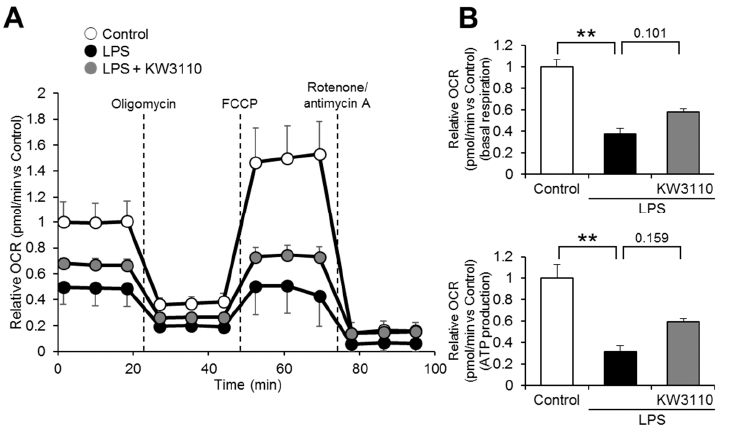
Figure 3. Effects of KW3110 treatment on mitochondrial respiratory function in LPS-stimulated J774A.1 cells. Mitochondrial respiration in cells was analyzed by an XFe24 Extracellular Flux Ana- lyzer. ( A ) Real-time measurement of OCR was performed with an XF Cell Mito Stress Test, using oligomycin (1 μ M), carbonyl cyanide 4-(trifluoromethoxy)phenylhydrazone (FCCP) (0.5 μ M), and rotenone/antimycin A (0.5 μ M), normalized to the control at 0 min. ( B ) Basal respiration was calcu- lated by subtracting the average relative OCR after rotenone/antimycin A injection from that before oligomycin injection. Respiration for ATP production was calculated by subtracting the average rel- ative OCR between oligomycin and FCCP injections from that before oligomycin injection, normal- ized to the control. Values represent means ± SEM. n = 5. Statistical differences were analyzed by analysis of variance (ANOVA) followed by Tukey’s test. ** p < 0.01.